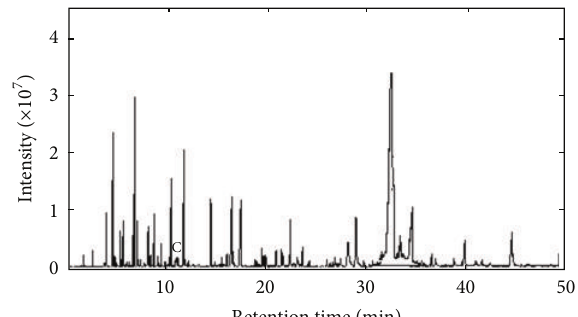
Figure 1: The chromatograms of the volatile components in main root of Agrimonia